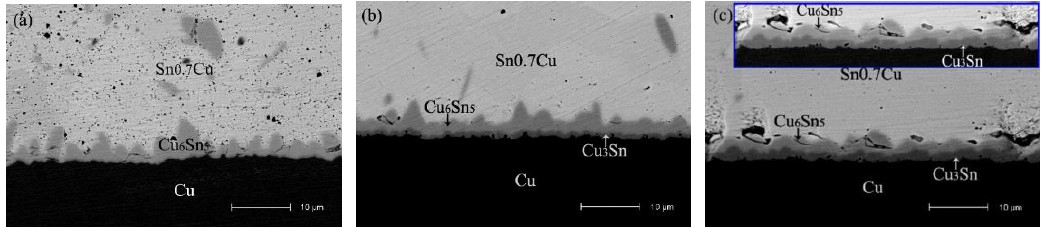
Figure 3. Interfacial microstructure of Sn0.7Cu/EP Cu joints after aging at 150 °C for ( a ) 0 h, ( b ) 240 h, and ( c ) 480 h.